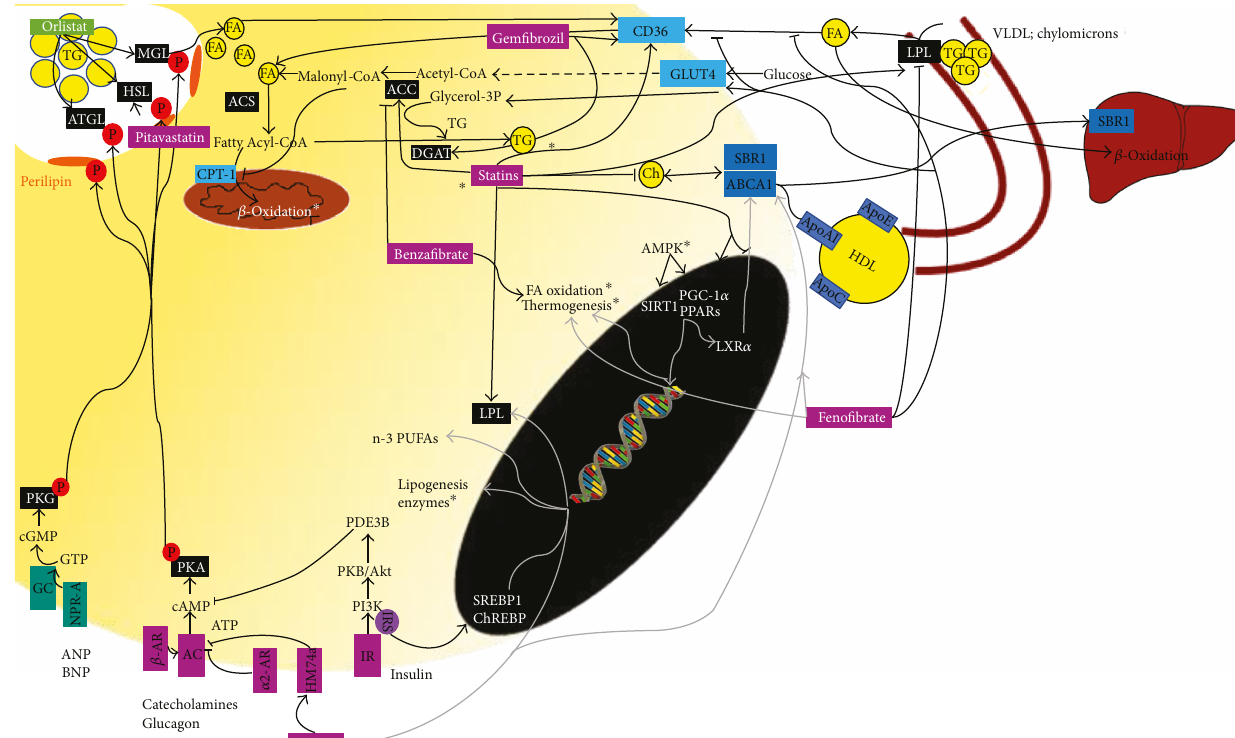
Figure 1: Schematic illustration of the main intracellular pathways and the e ff ects of drugs used in dyslipidemia and obesity in (A) di ff erentiation of preadipocytes into mature adipocytes. This process is on dependence of the PKA pathway, which activates transcriptional factors such as C/EBPB, C/EBPd, C/EBPa, and PPARG that ultimately lead to increase of adipogenesis gene expression. Statins and liraglutide inhibit adipogenesis while niacin and fi brates stimulate, by inducing upregulation of adipogenesis genes ( ∗ leptin; adiponectin, FABP4, perilipin, and GLUT4, SCD1) expression and (B) immune and endocrine functions of WAT. Adipocyte exerts autocrine and paracrine actions, through secreting adipokines and also endocrine actions in distant organs. Most of the drugs exhibit an anti-in fl ammatory role through modulation of adipokine expression. Through modulation of leucocyte chemotaxis, they also a ff ect NK cell activity and macrophage phagocytosis. See text for more details. → : stimulates; ⊣ : inhibits; AC: adenylyl cyclase; cAMP: cyclic adenosine monophosphate; PKA: cAMP-dependent protein kinase A; C/EBP: CCATT enhancer-binding proteins; PPARs: peroxisome proliferator-activated receptors; SREBP1: sterol regulatory element-binding protein-1; RXT α : retinoid X receptor- α ; SRE: sterol response elements; SRB1: scavenger receptor 1; NK cells: natural killer cells; CD40: cluster of di ff erentiation 40; CD40L: CD40 ligand;